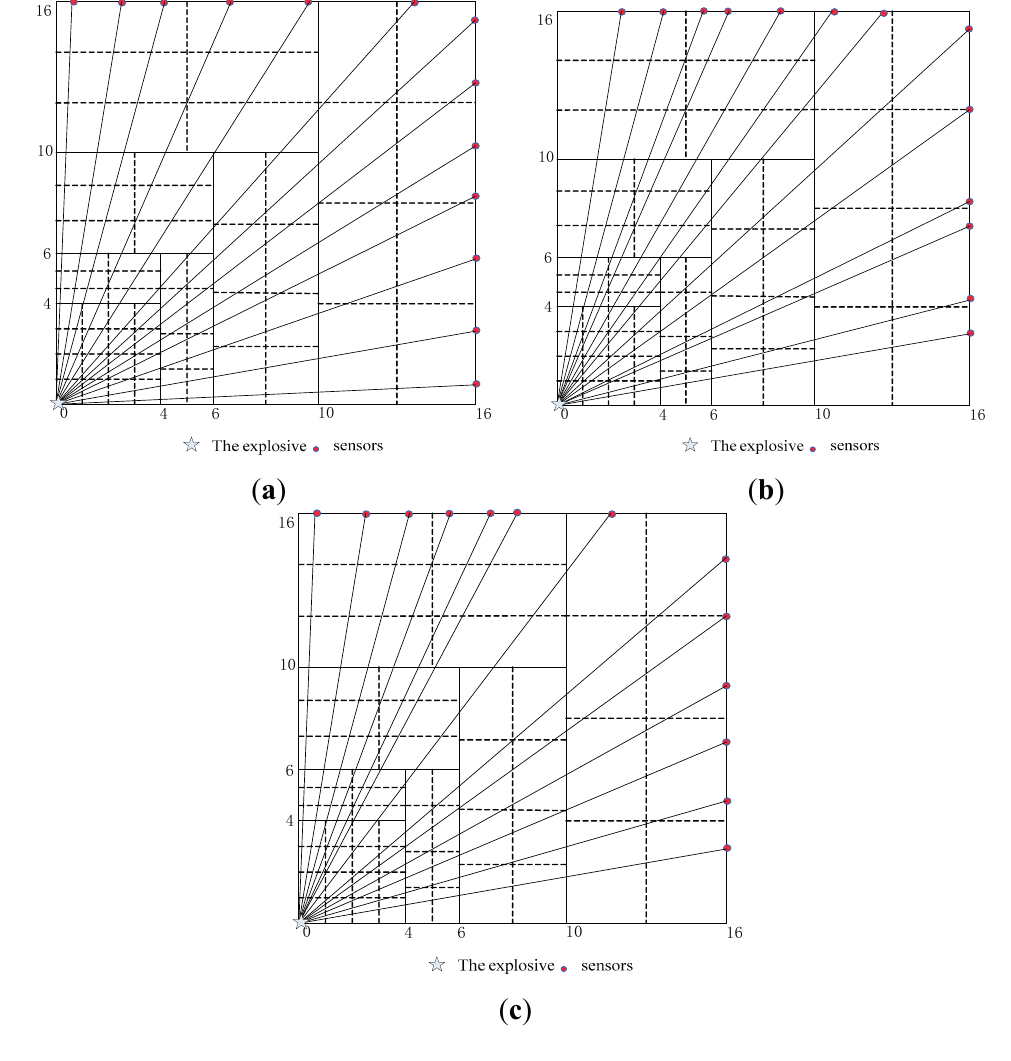
Figure 5. Different sensor distributions, respectively in each case. ( a ) Symmetrical sensor distribution; ( b ) Random sensor distribution; ( c ) Optimum sensor distribution.